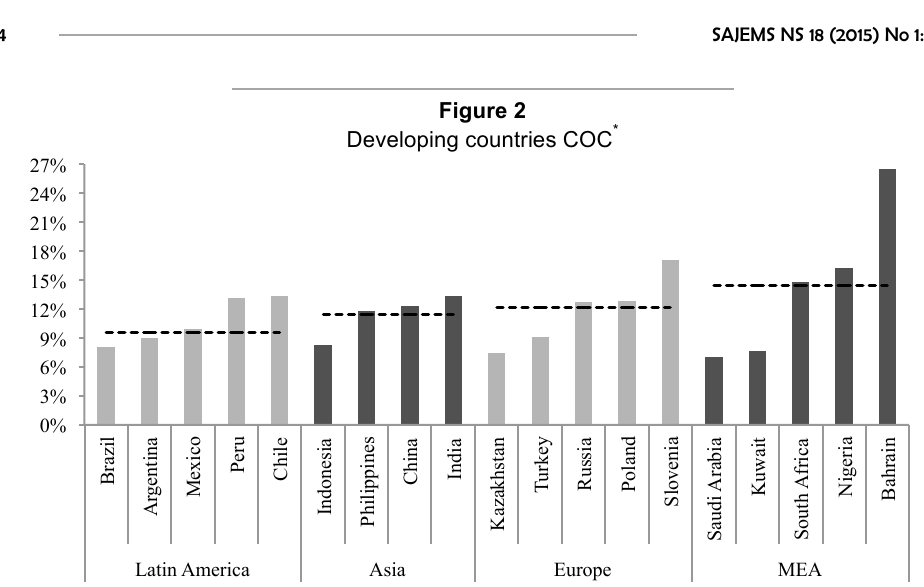
*Dashed lines indicate regional